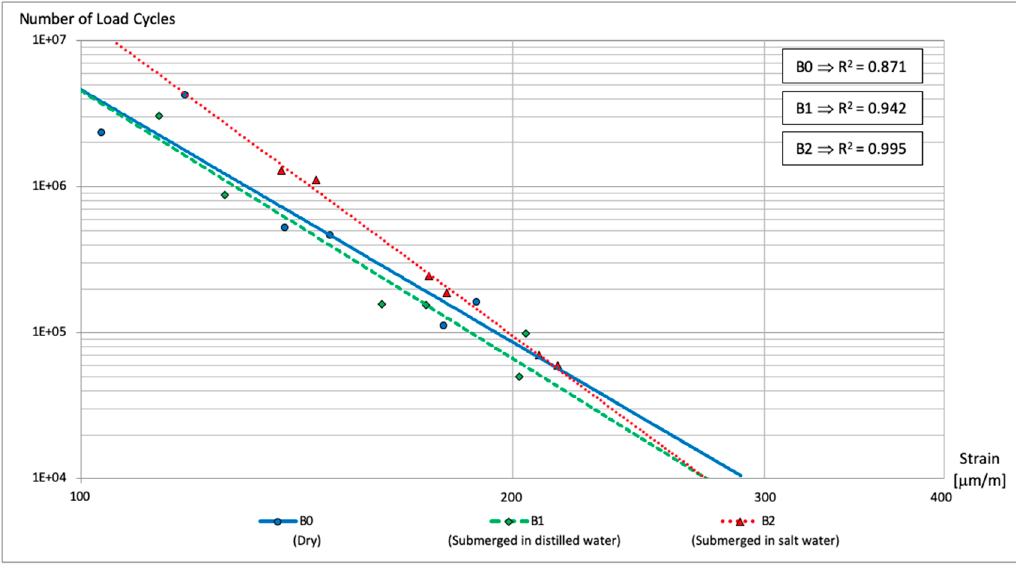
Figure 5. Fatigue test: specimens subjected to five freeze–thaw cycles.